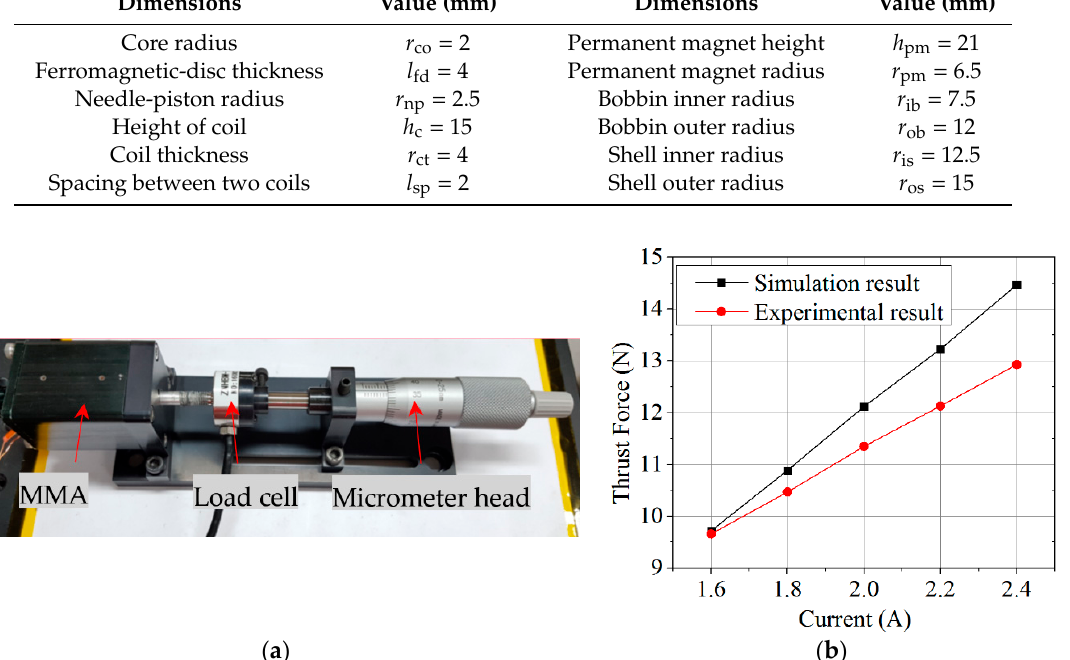
Figure 6. Measuring driving force. ( a ) Measuring system; ( b ) comparison of experiment and simulation results .